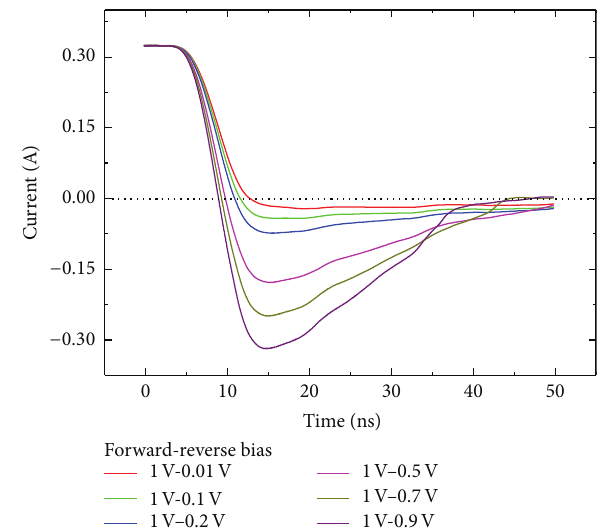
Figure 4: Reverse recovery current transient recorded on the diode as a function of varying initial reverse bias.